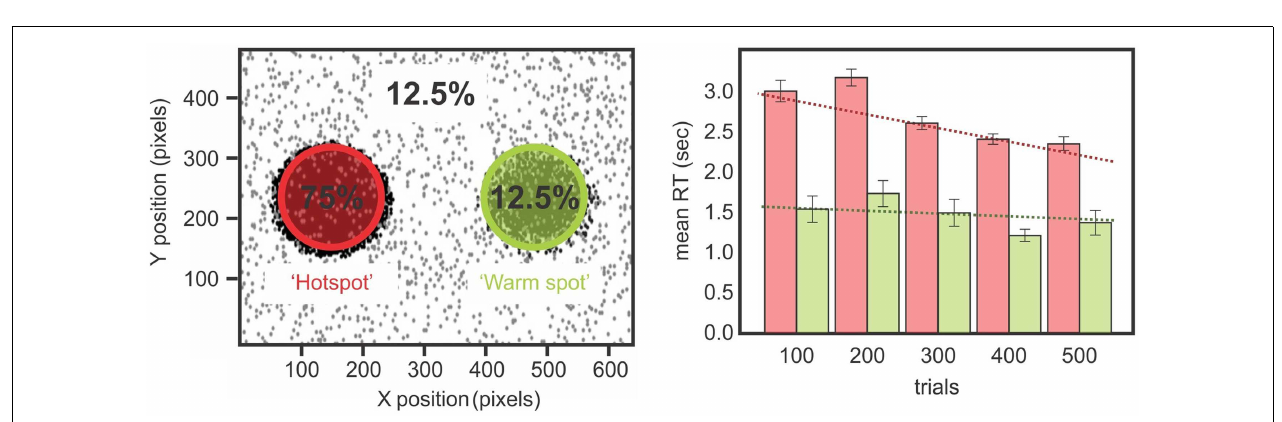
FIGURE 6 | Left panel: images used in one trial of the ambiguous figures task . In this example a swan morphs into a cat.The middle image (#8) is highlighted overlaid on the first (swan) and last (cat) images in red to highlight the ambiguous interpretation for the middle image.The four image sets used are indicated below. Right panel: data